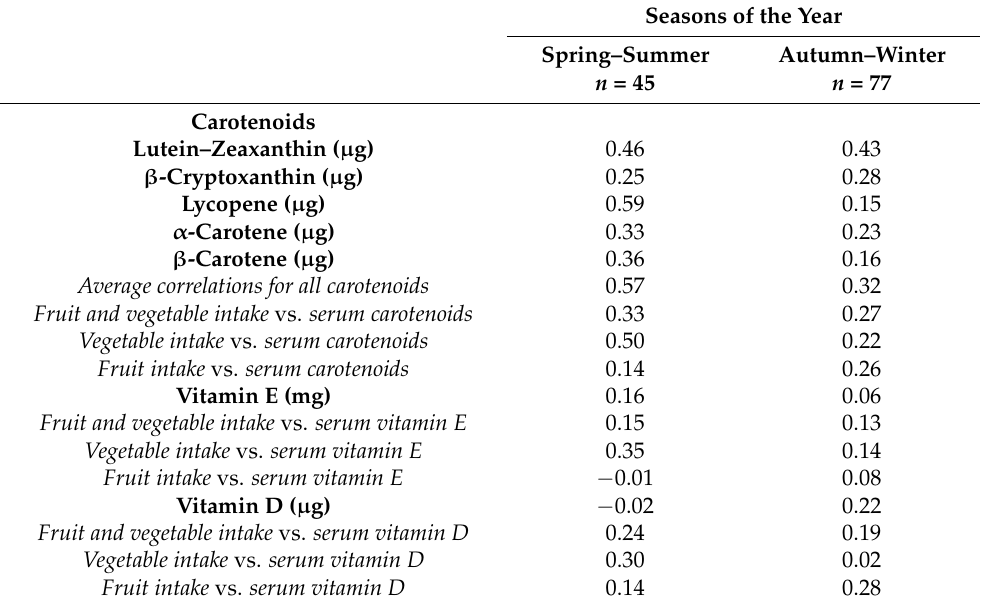
Table 3. Correlation coefficients between energy-adjusted intakes from FFQ and serum concentration of vitamins by season of the year in adolescents aged 15–17 years of the INMA-Granada study ( n =